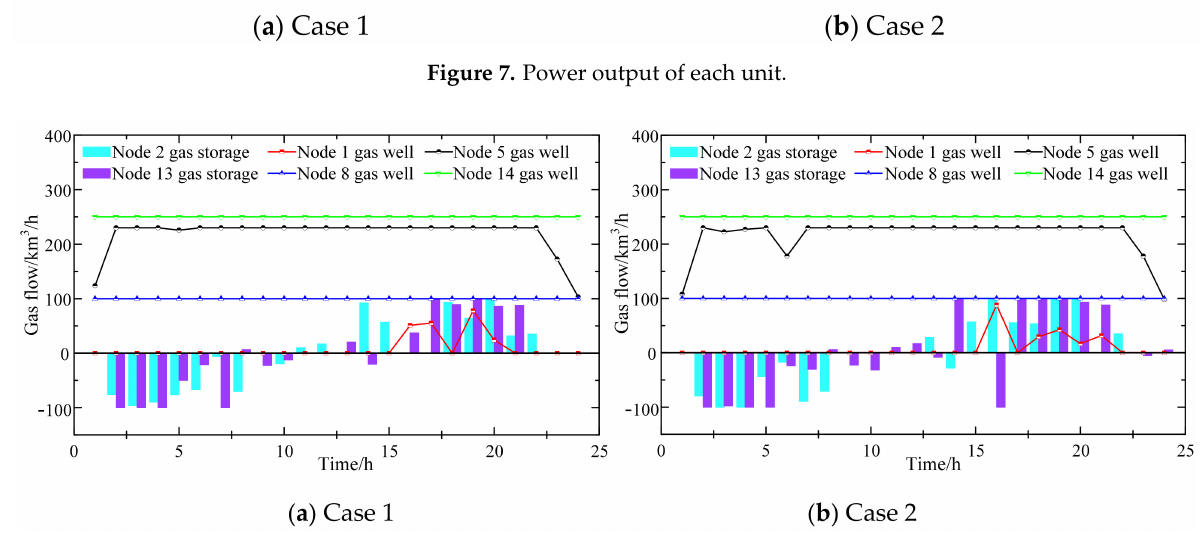
Figure 8. Gas flow.